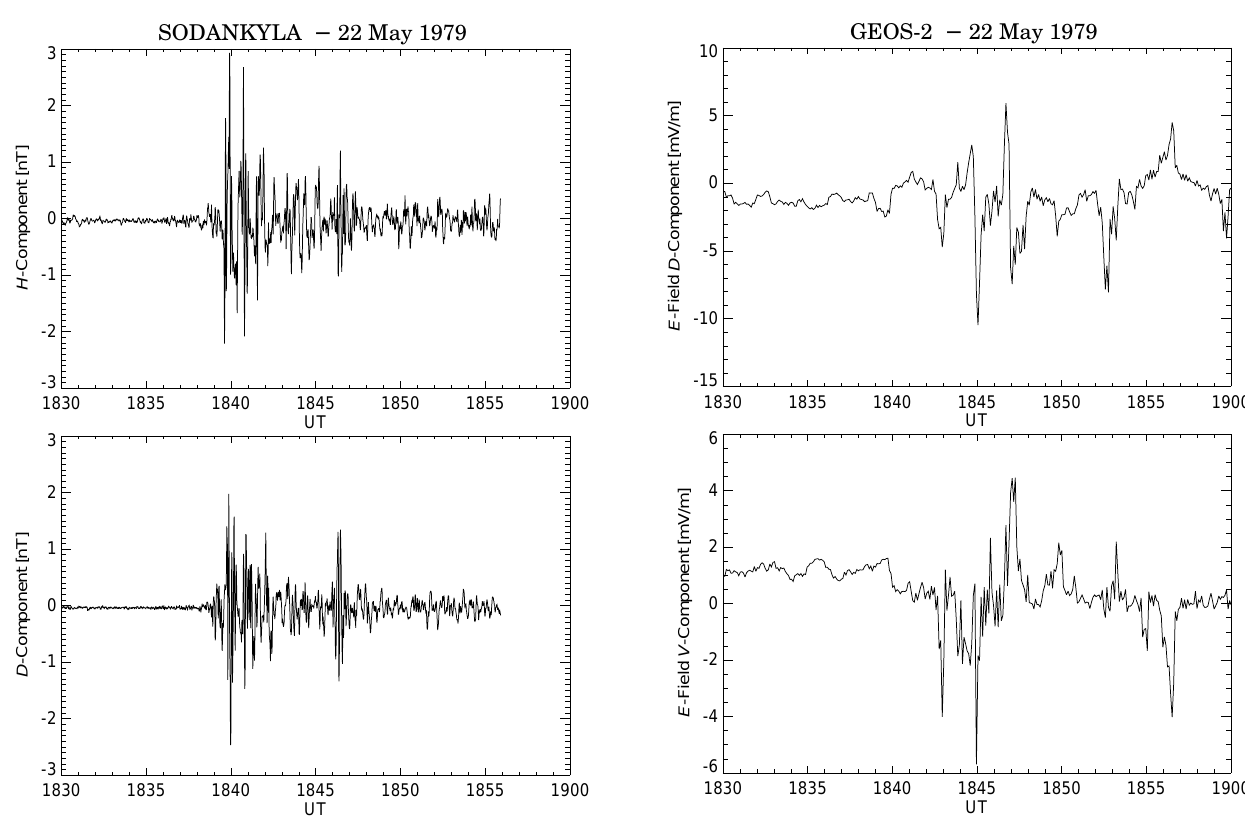
Fig. 6. Electric field V- and D-components recorded on GEOS-2 as functions of